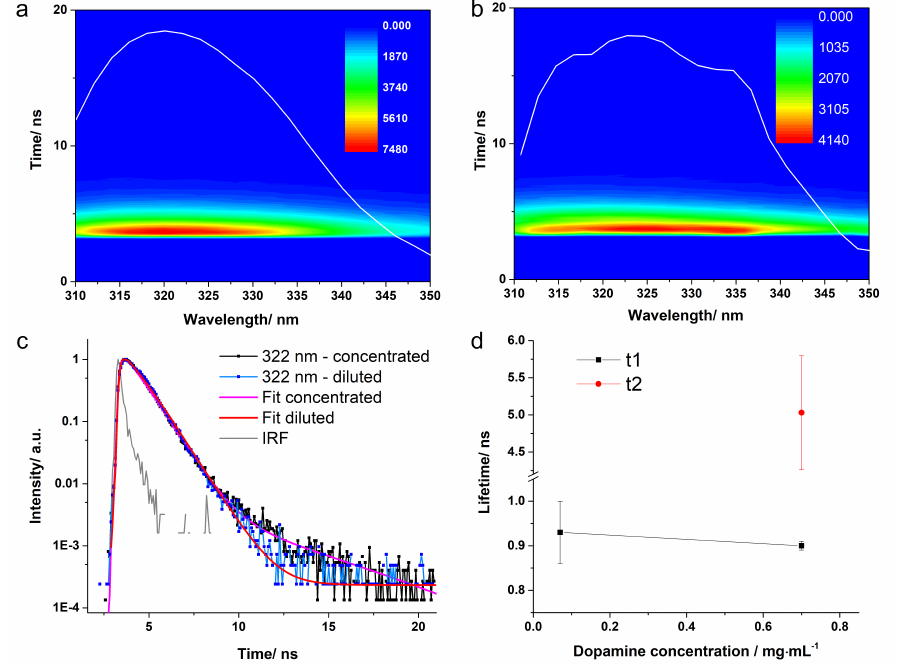
Figure 5. Time-correlated single-photon counting (TCSPC) 3D data carpet obtained from the concen- trated ( a ), respectively diluted ( b ) DA solution at pH = 5.5 following excitation at 280 nm. The white line represents the integrated fluorescence spectrum. Normalized kinetic traces recorded at 322 nm with the fitted curves ( c ). The average lifetimes obtained for each solution ( d